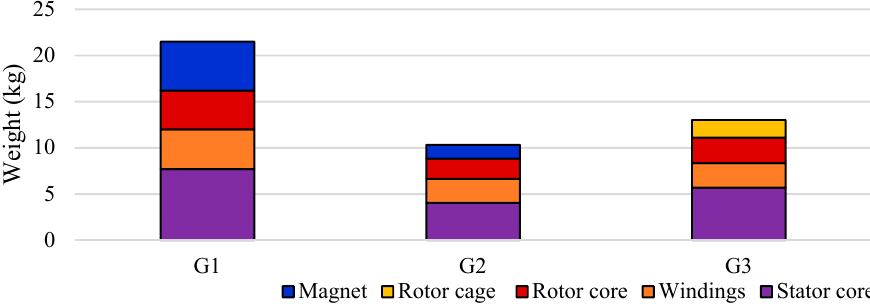
Figure 9. Weight comparison of G1, G2, and G3.